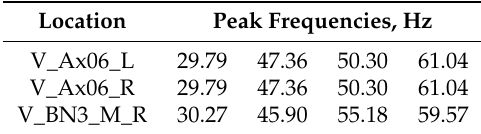
Figure 8. The vibration acceleration spectrogram on the axle at the vertical direction of each left and right side of the number 6 axle V_Ax06_L and V_Ax06_R: ( left ) 3D spectrogram of FFT analysis of vibration acceleration with train speed at V_Ax06_L, ( right ) 3D spectrogram of FFT analysis of vibration acceleration with train speed at V_Ax06_R. The wheel rotation speed (wheel diameter 860 mm) and its integer multiples (harmonic frequencies) are plotted with red lines in the spectrograms. Table 1. Main peak frequencies in the vertical vibration measurements in the axle and bogie. Location Peak Frequencies,